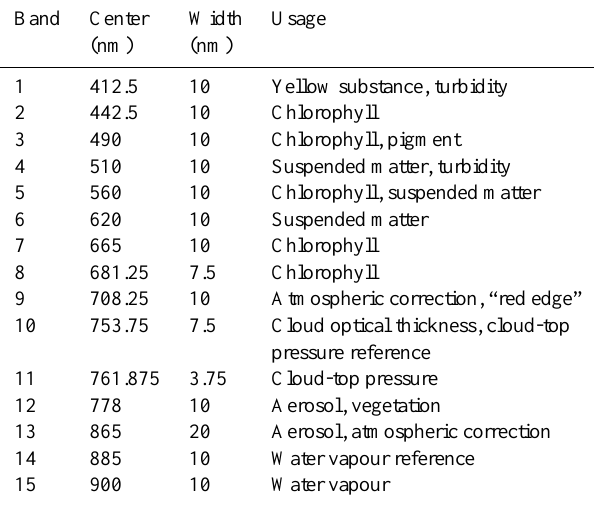
Table 1. Central wavelength and bandwidth (fwhm) of MERIS spectral